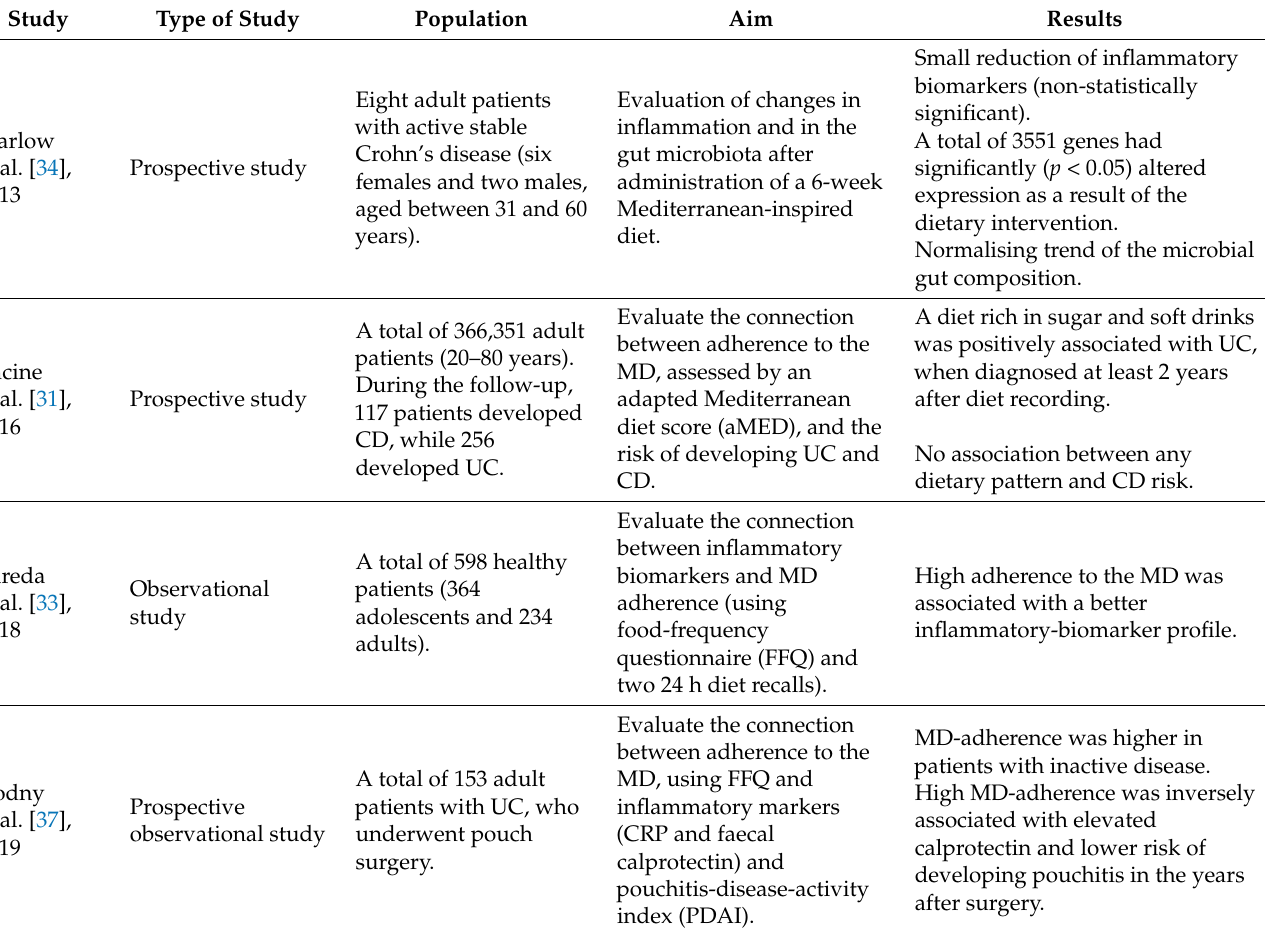
Table 1. Main characteristics of the studies regarding the impact of a Mediterranean diet on Inflam- matory Bowel